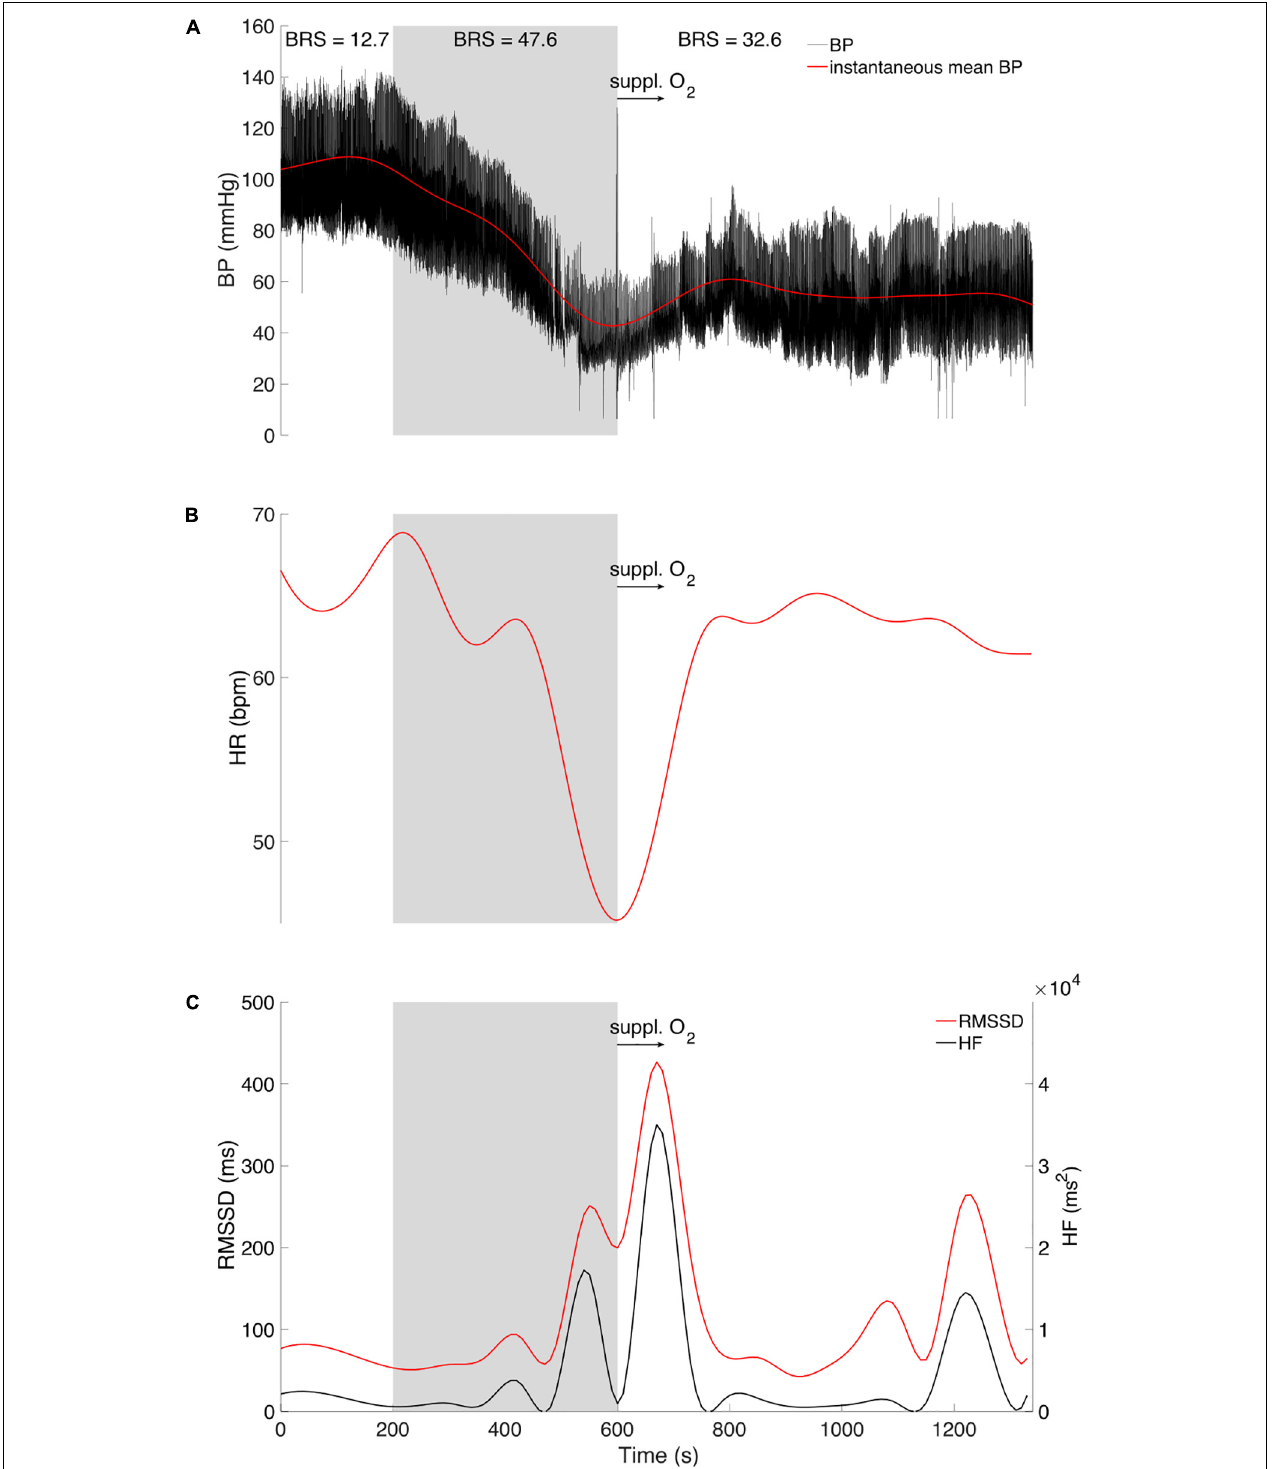
FIGURE 1 | Original tracing of instantaneous (A) arterial blood pressure (BP, black trace) and mean value (red trace), (B) Heart rate (HR) in red tracing, and (C) Root mean square of the successive differences (RMSSD, red trace) and high frequency power (HF, black trace). Displayed for three phases: Baseline (0–200 s), vasovagal reaction (gray area, 200–600 s), and recovery period (600–1200 s) with brief 100% medical oxygen administration (black arrow, 600–700 s). Baroreflex sensitivity (BRS) is presented for each of the three phases.